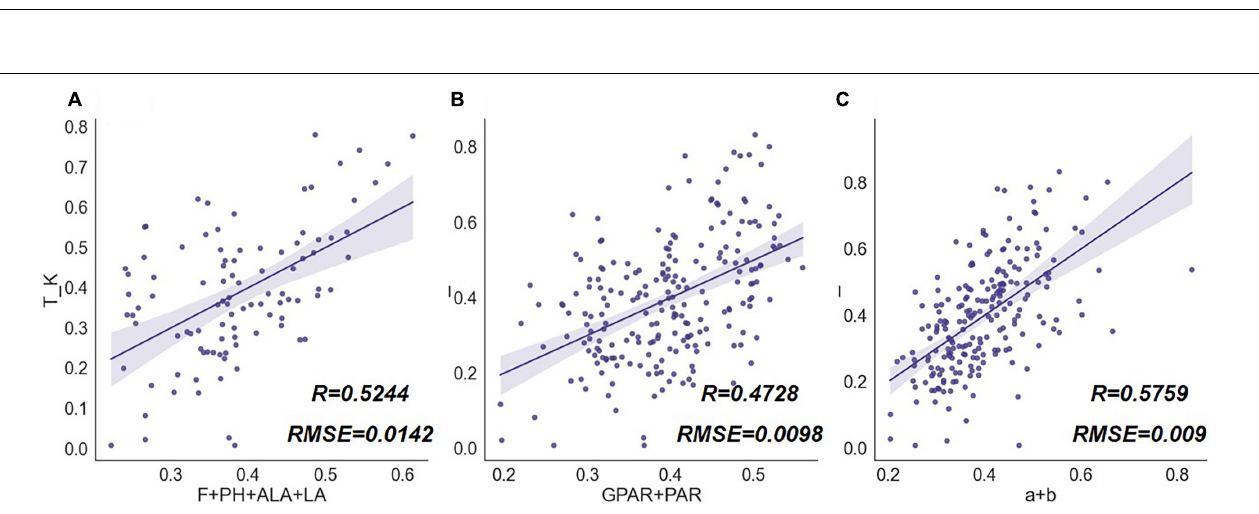
FIGURE 15 | MLR results of phenotypic trait combinations and extinction coefficient ( K ). The scatter graphs show the Pearson correlation test results between the regression values and the true measurement values. The x -axis represents the K values derived from the regression model, and the y -axis represents K values measured by a radiometer. Different combinations of rice traits are (A) [ F , PH , ALA , LA ], (B) [ GPAR , PAR ], (C) [ a , b ].